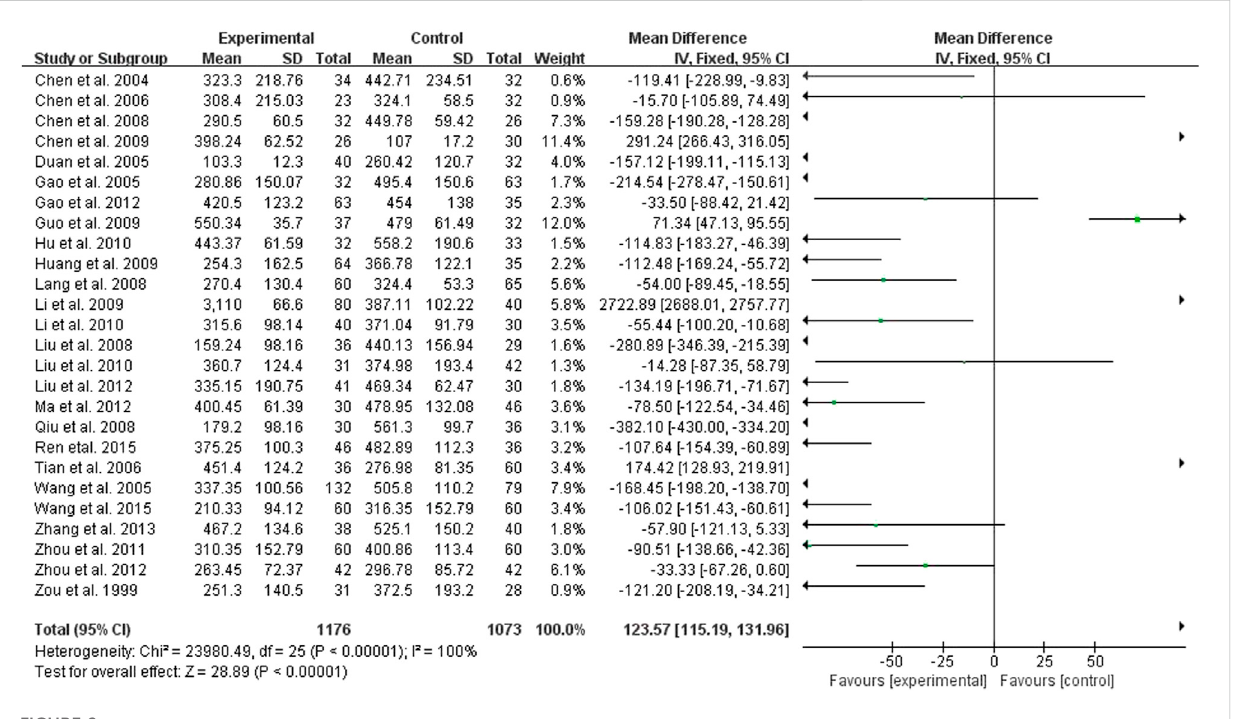
FIGURE 2 Forest plots showing MD (with 95% CI) for SCR comparing Rhubarb with the usual